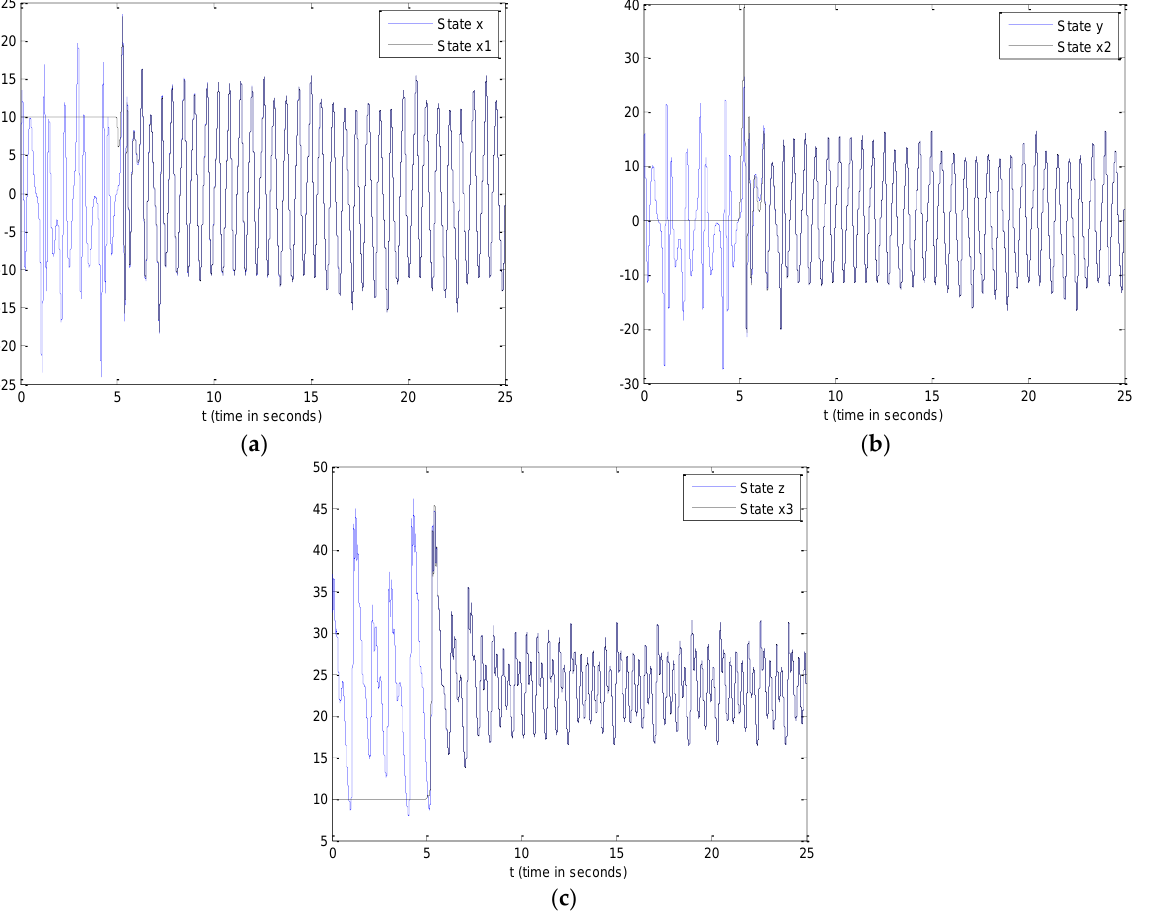
Figure 8. Fractional order derivative with α = 0.9, 0.8, and 0.5 and time delay τ = 5 s. Time response plots of time-delay synchronized states of master and slave: ( a ) First state ( x − x 1 ) of master and slave; ( b ) second state ( y − x 2 ) of master and slave; ( c ) third state ( z − x 3 ) of master and slave.